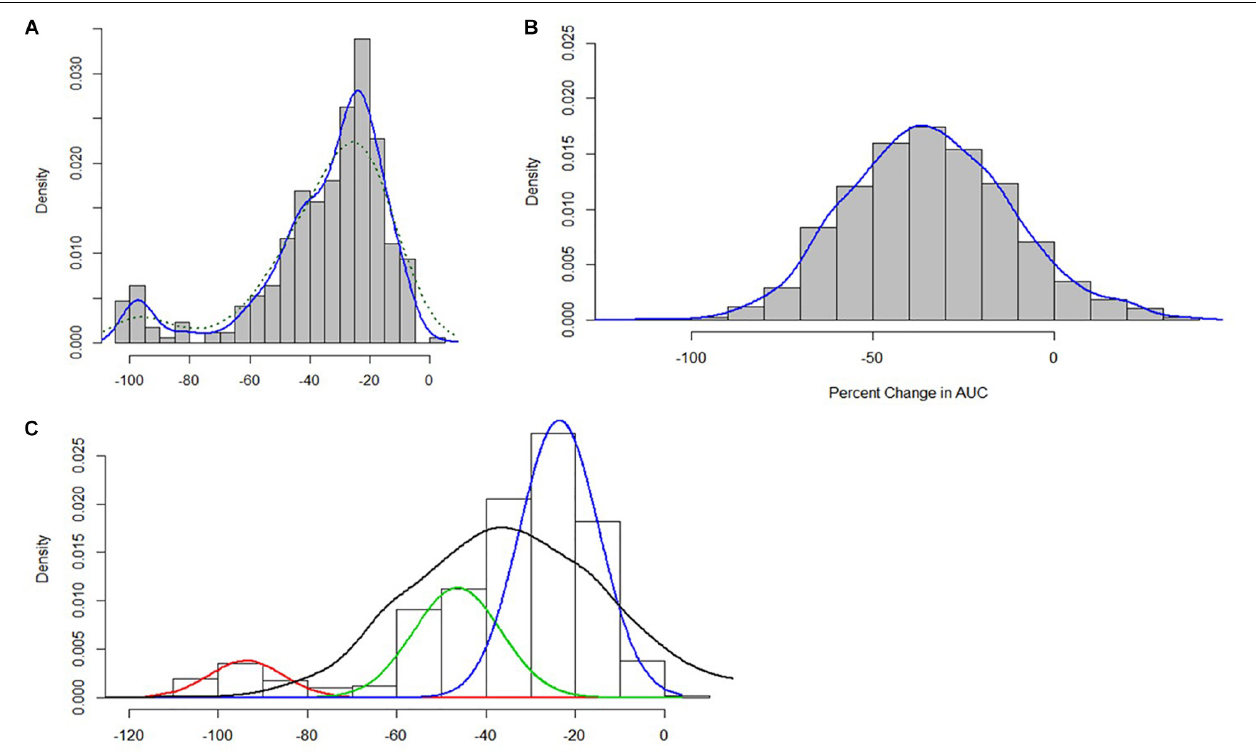
FIGURE 3 | (A) Distribution of nisin stress response (cid:49) PAUC values for the 356 L. monocytogenes strains (B) (cid:49) PAUC assuming a homogeneous normal distribution (C) Mixture distributions underlying the (cid:49) PAUC.